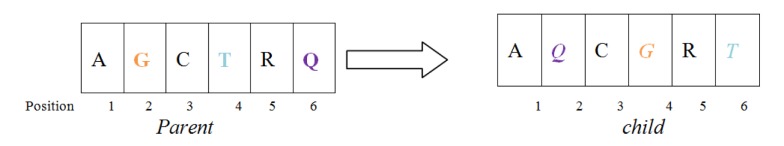
Position mutation operator